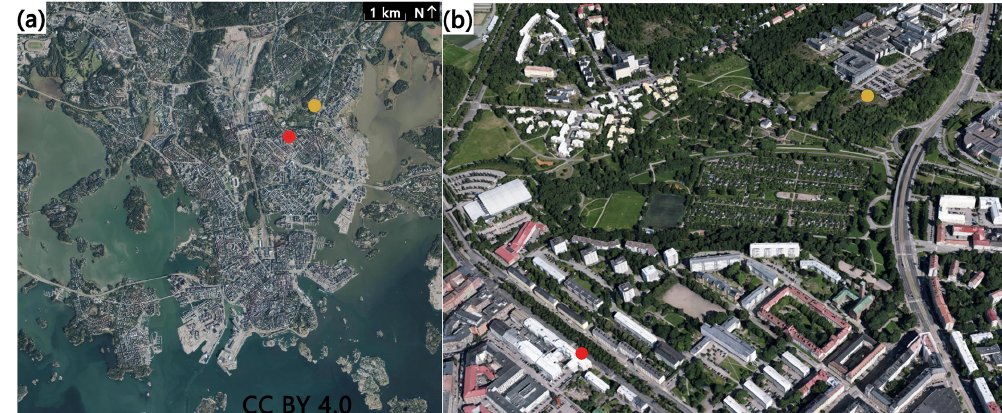
Figure 1. Aerial photography (a) and 3D model (b) of stations: street canyon (red) and background (yellow). The photograph and the model were provided by the city of Helsinki map service (CC BY